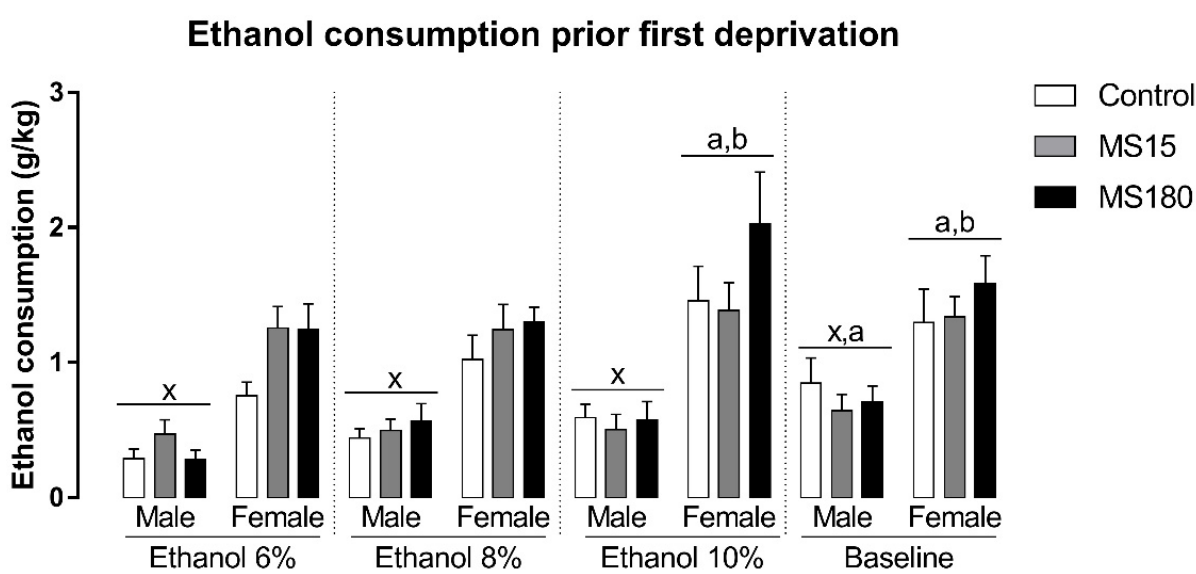
Figure 2. Ethanol intake before deprivations in female and male rats exposed to brief and prolonged maternal separation. Bars represent the mean ± SEM (n = 11–14 animals/group). Each concentration represents the average intake of the 4 days of exposition in each experimental phase of the proce- dure. x; p < 0.05 when compared to female groups of the same experimental phase, independent of manipulation; a, p < 0.05 when compared to the ETOH 6% phase of the same sex, independent of manipulation; b, p < 0.05 when compared to ETOH 8% phase of the same sex, independent of manip- ulation; c, p < 0.05 when compared to ETOH 10% phase of the same sex, independent of manipulation. ETOH, ethanol; MS15, brief maternal separation; MS180, prolonged maternal separation.